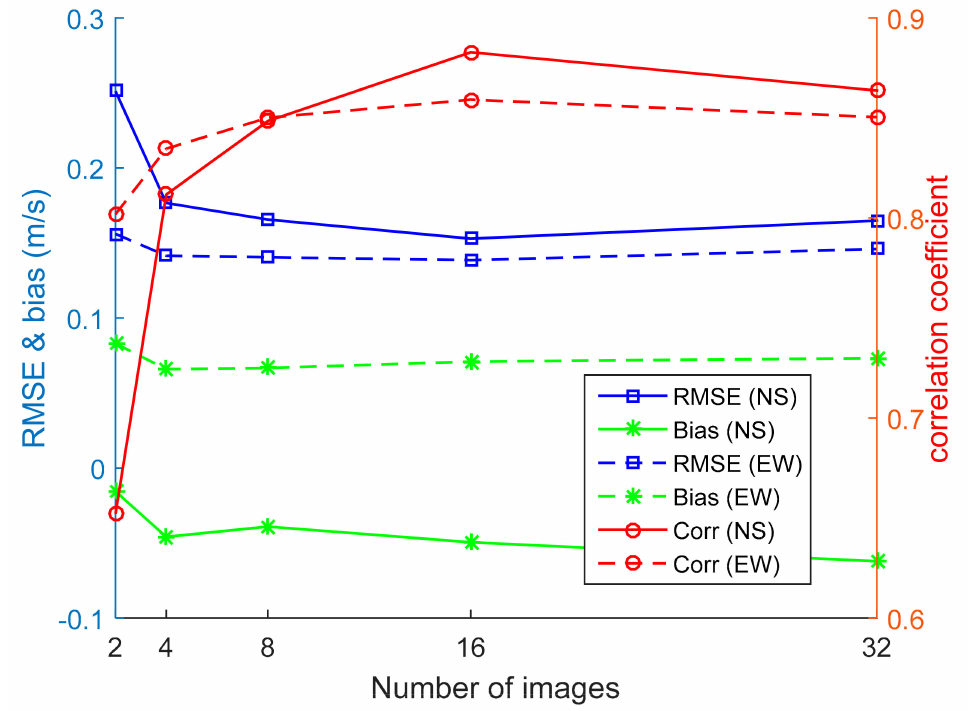
Figure 9. The RMSE, bias and correlation coe ffi cient between the current velocities measured by a current meter and those retrieved from di ff erent numbers of X-band marine radar